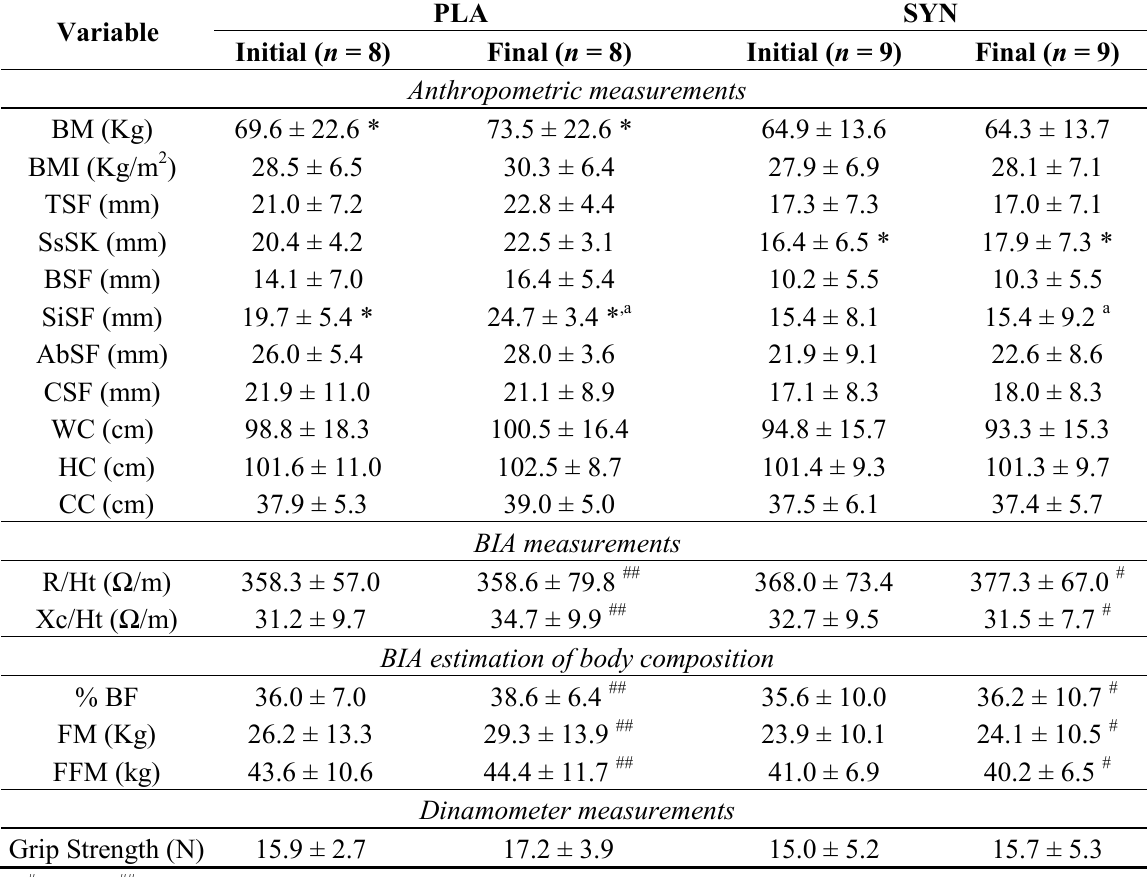
Table 1. Variables evaluated before and after the supplementation.